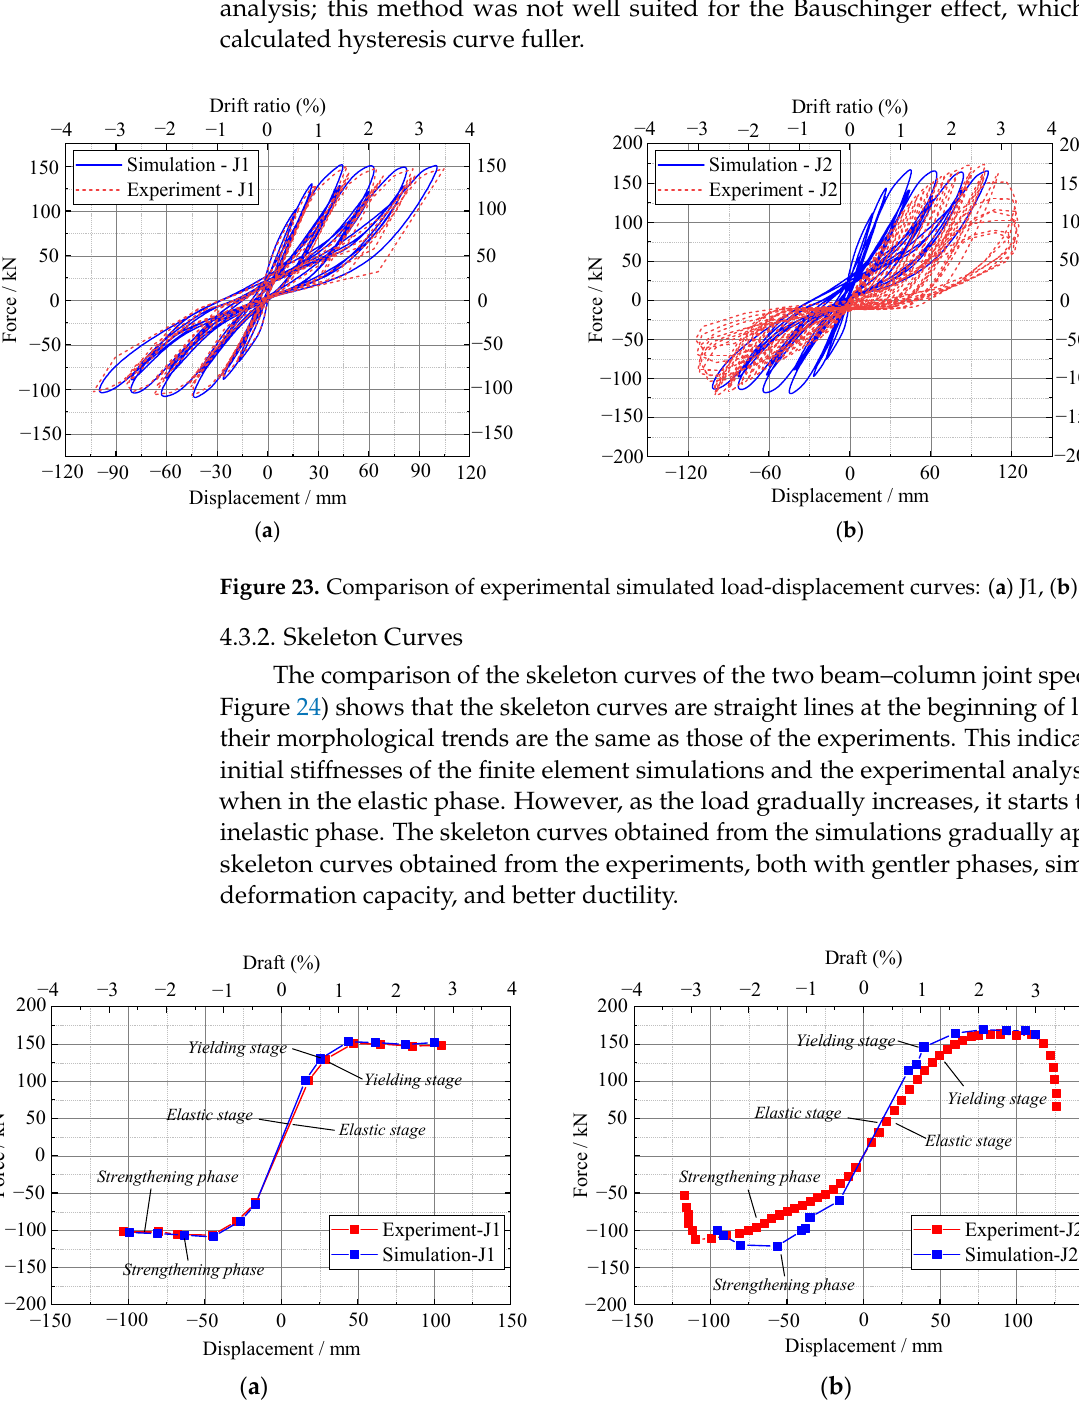
( b ) Figure 22. Boundary conditions and loading settings. ( a ) Top of column coupled to end of the beam; ( b ) bottom of a column fixed. 4.3. Analysis of Calculation Results 4.3.1. Hysteresis Curves The experimental and numerical simulation load-displacement curves for specimens J1 and J2 are shown in Figure 23. The simulated curves of J1 and J2 are fuller than the experimental curves, and the hysteresis loop area is larger, indicating that the new joints had better energy dissipation performance. However, the finite element simulation pro- cess is more idealized than the actual experiments, and the simulation results are fuller